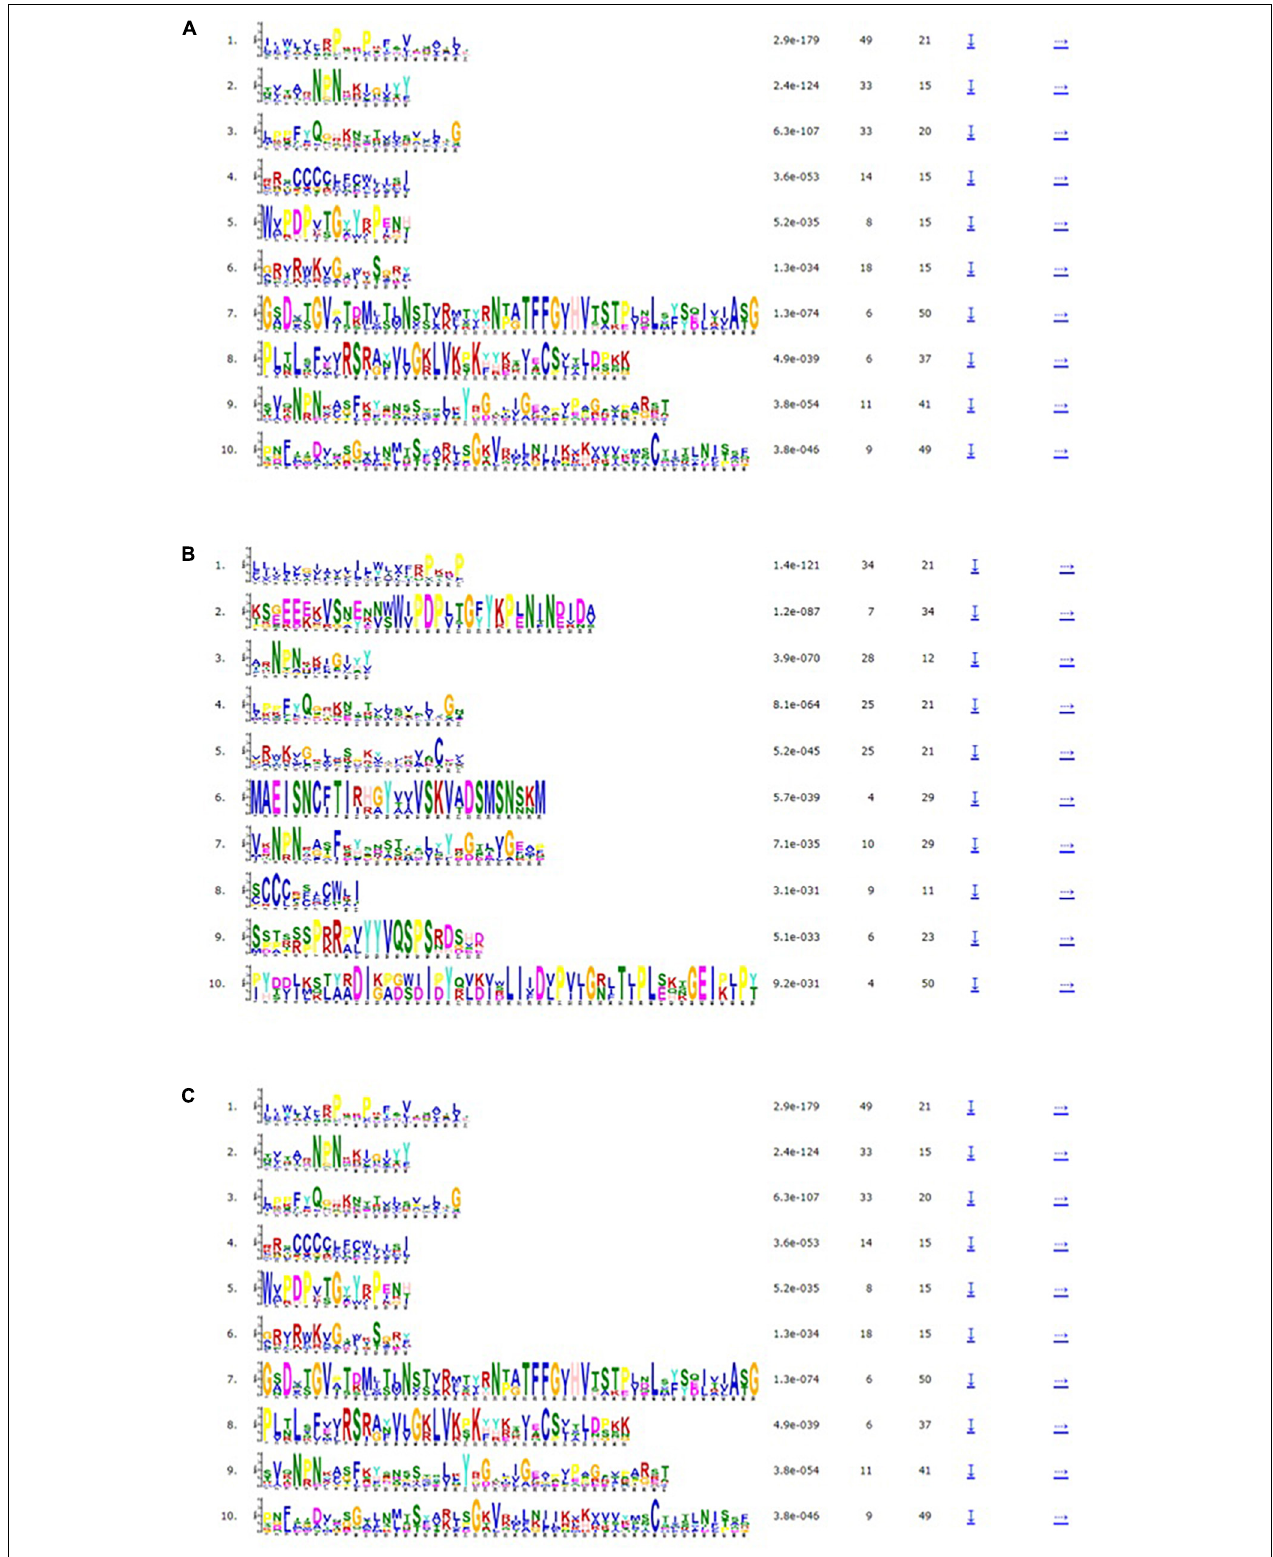
FIGURE 6 | Motif analysis of (A) VrLEA , (B) VaLEA , and (C) VuLEA genes.